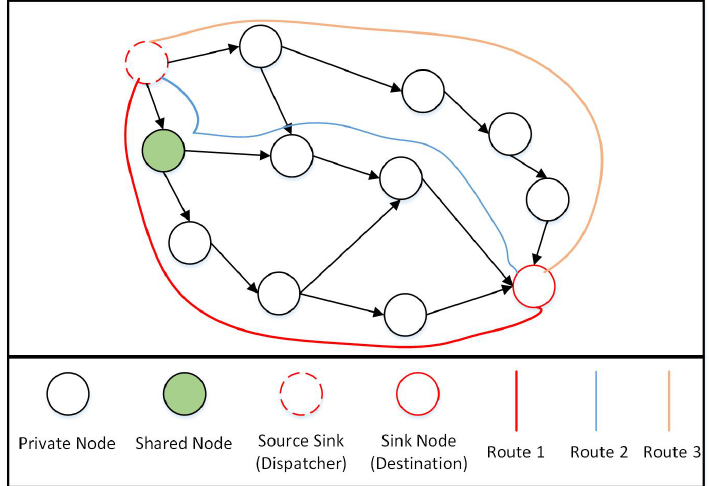
Figure 3. Principle and Working flow of the Algorithms.